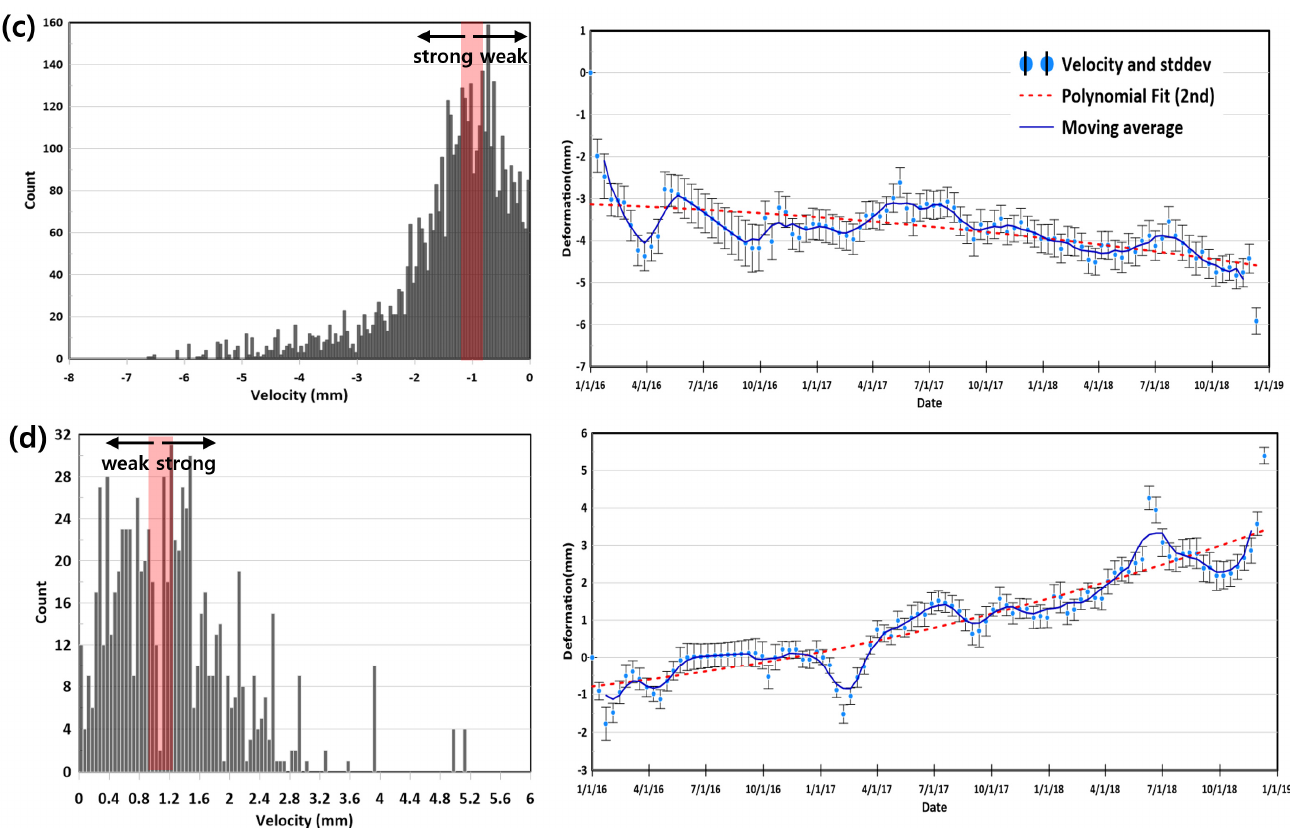
Figure 8. Distribution of LTDPs on ( a ) spatial analysis mask and pahoehoe lava flow and ( b ) geological units together with estimated clusters implying potential lava tube networks. ( c ) Histogram of V-migration points and average deformation/standard deviation/2nd polynomial regression of strong V-migration points and ( d ) Histogram of H-migration points and average deformation/standard deviation/2nd order polynomial regression of strong H-migration points.